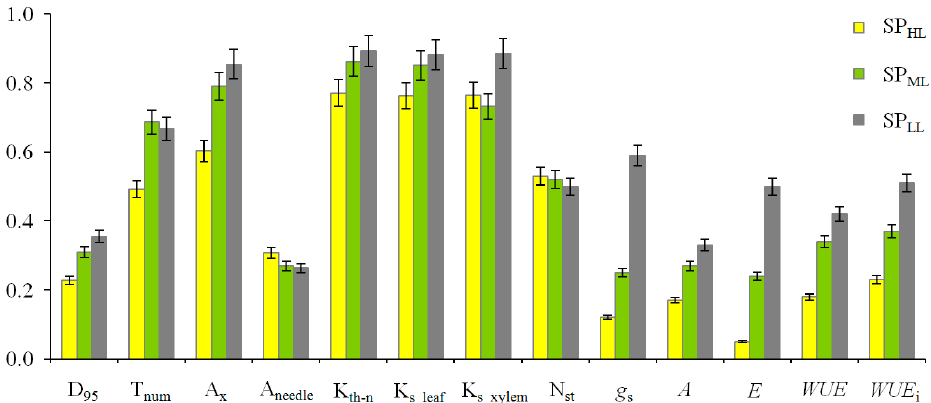
Figure 2. Plasticity index (PI) of needle xylem traits and leaf gas exchange parameters in the clear-cut SP HL , in the shaded clear-cut SP ML , and in the forest SP LL .